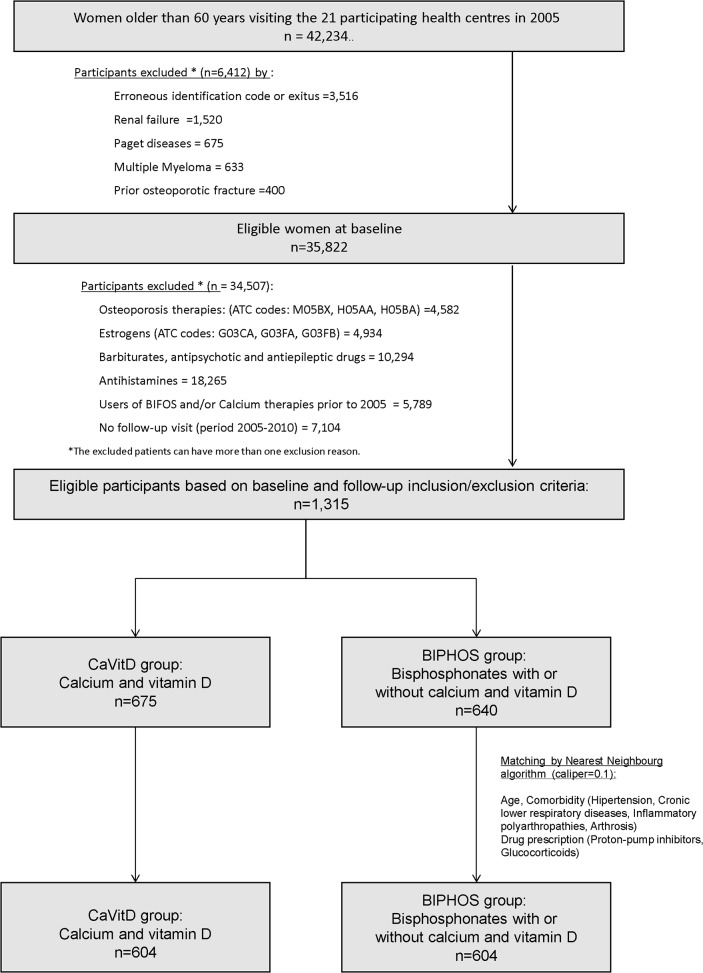
Flow chart showing the participants’ selection process.